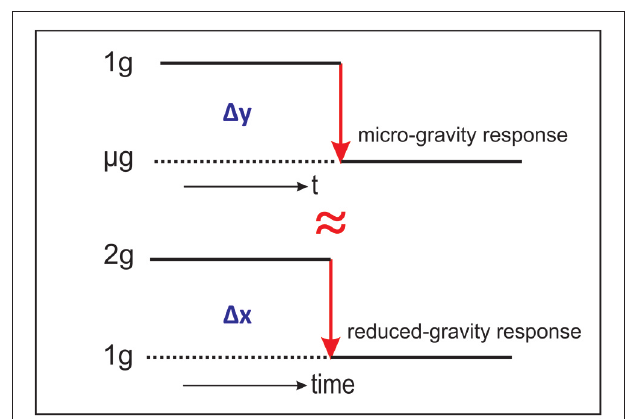
FIGURE 1 | Graphic representation of the Reduced Gravity Paradigm, RGP. Delta between µ g and 1g is (nearly) the same as between 2 and 1 g.